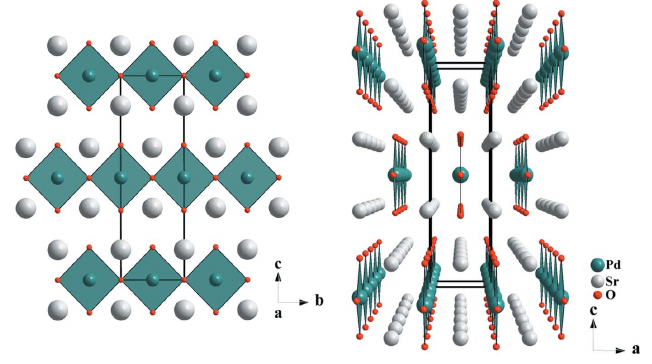
Figure 3 Coordination polyhedra of two types of oxygen atoms, O1 (left) and O2 (right). All atoms are drawn with displacement ellipsoids at the 80% probability level. Distances are in A˚ .